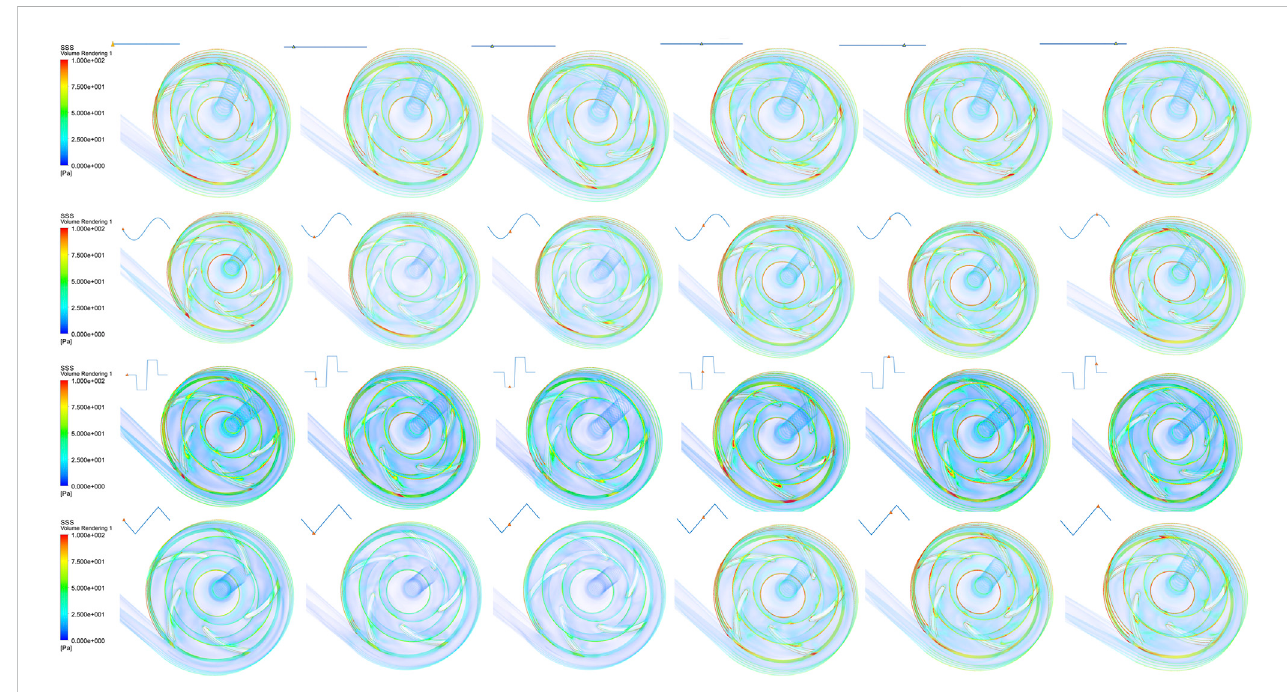
Scalar shear stress (SSS) distributions under constant speed and sinusoidal, square, and triangular speed modulation